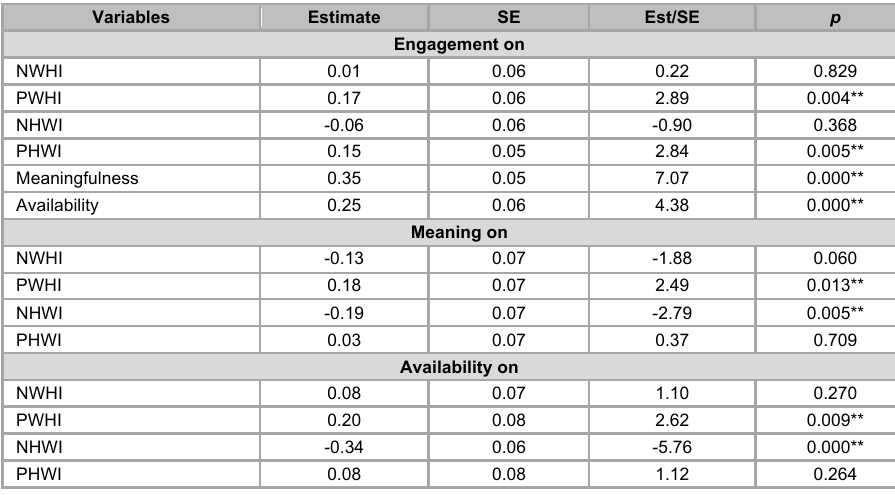
Standardised regression coefficients of the variables